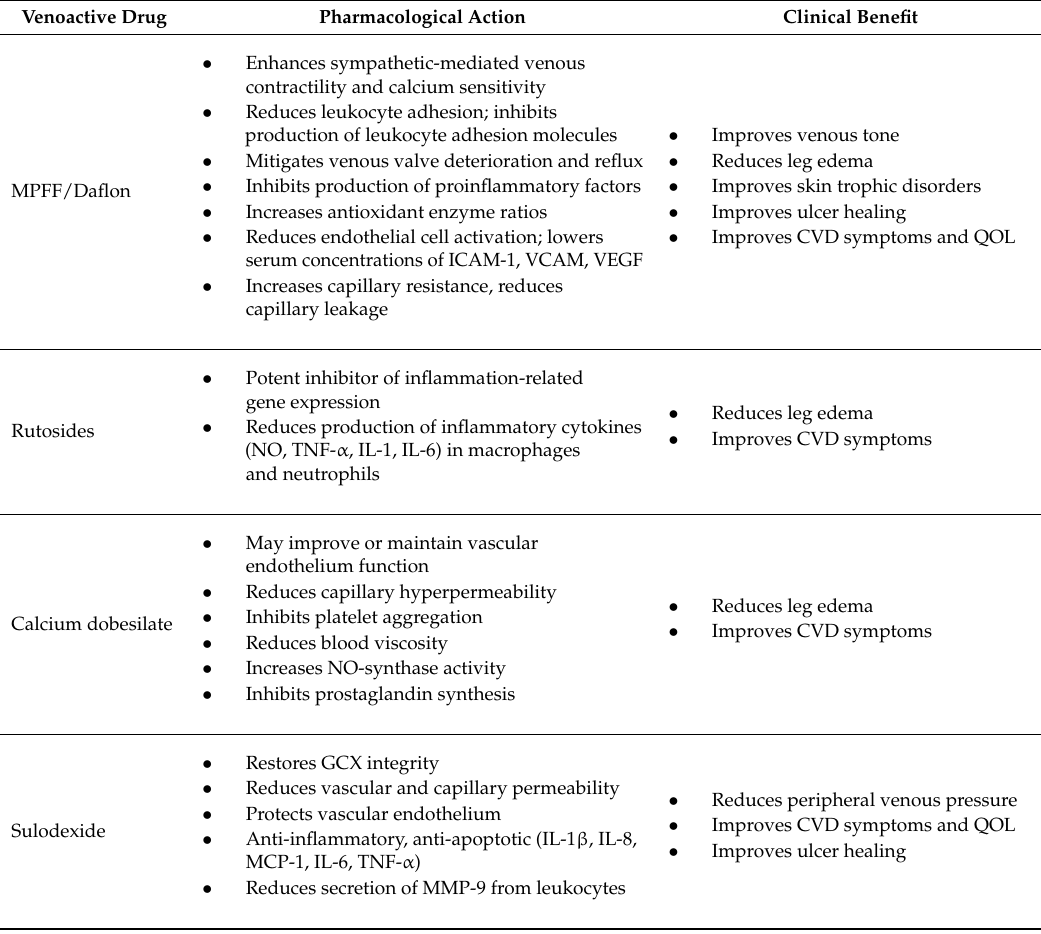
Table 2. Pharmacological effects of venoactive